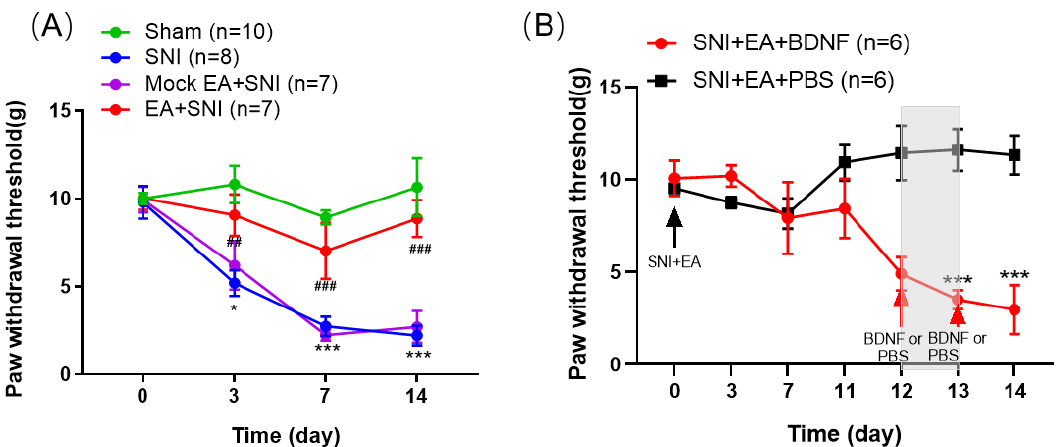
Figure1. 2Hzelectroacupuncture(EA)treatmentrelievedsparednerveinjury(SNI)-inducedmechanical hypersensitivity in rats. ( A ) Rats were treated with 2 Hz EA, starting from day 1 post-SNI surgery, once every other day lasting for 14 days ( n = 7–10). The PWT was measured on days 0, 3, 7, and 14 post-SNI operation. Sham represents the sham group; SNI represents rats treated with the spared nerve injury-elicited neuropathic pain; SNI + EA represents rats receiving spared nerve injury and EA treatment. Mock EA + SNI represents rats receiving spared nerve injury and EA only stimulates acupoints, no electrical stimulation. ( B ) Following 2 Hz EA treatment of SNI rats, intrathecally injected 100 ng BDNF or PBS to SNI rats on day 12 post-surgery. BDNF + EA + SNI and PBS + EA + SNI represents rats receiving intrathecal administration of 100 ng BDNF or PBS ( n = 6 per group). * p < 0.05, *** p < 0.001, compared with the sham group. ## p < 0.01, ### p < 0.001, compared with the SNI group. All data were expressed as mean ± SEM, two-way repeated-measures ANOVA was followed by Bonferroni’s post-hoc